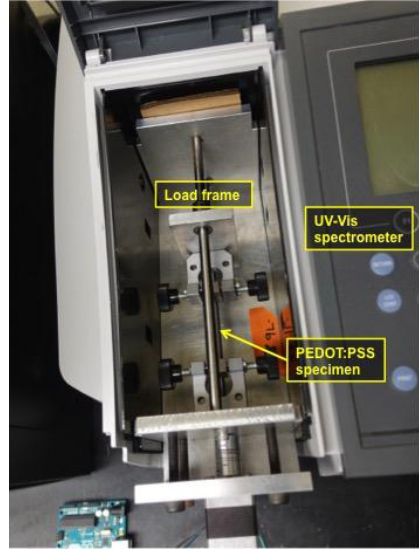
Figure 2. An UV-Vis spectrophotometer equipped with a custom-built load frame, which fits in measurement chamber, measures optical spectrum of the thin film specimens at various tensile strains.